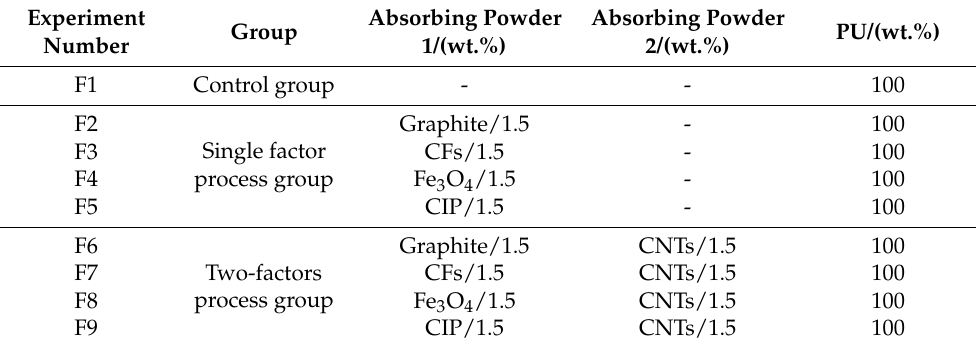
Table 1. Preparation scheme of microwave-absorbing film for the general performance